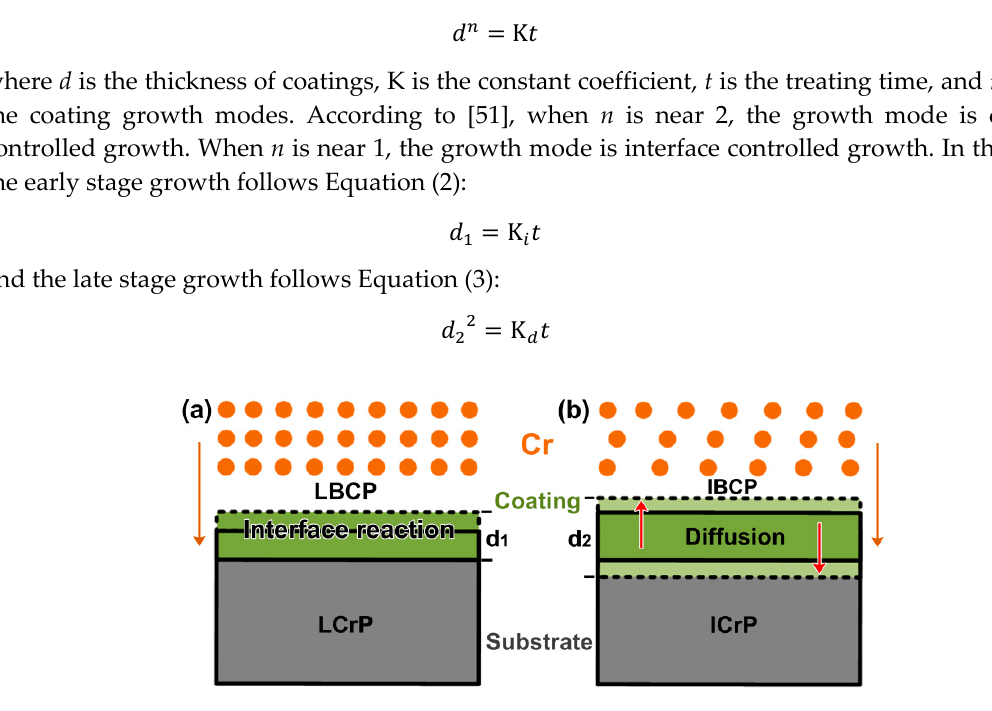
Figure 7. Sketch maps to exhibit the different growth modes during the chromizing process: ( a ) at early stage; ( b ) at late stage. Arrows present the main diffusion directions: the orange arrow mainly represents the diffusion direction of chromium, and the red arrow mainly represents the diffusion direction of boron. LCrP, LBCP, ICrP and IBCP represent lower Cr potential, lower B and C potential, increasing Cr potential and increasing B and C potential, respectively.